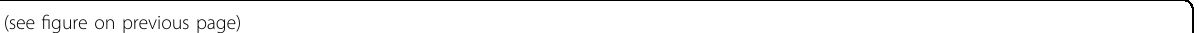
Fig. 2 Single-agent APG-115 signi fi cantly reduces the leukemic burden and prolongs survival in systemic TP53 wt MOLM-13 AML xenografts. A Study schema of the experimental paradigm to study tumor burden and animal survival in the systemic MOLM-13 AML model. For CD45 analysis, mice were treated with APG-115 for 15 days. For survival analysis, mice were treated with APG-115 for 21 days. B Representative fl ow cytometry results show tumor burden (i.e., engraftment of human CD45 + cells) in murine femoral bone marrow and spleen. Five or six mice treated as in A from each treatment group were euthanized and examined on Day 15. C Signi fi cantly lower proportions of human CD45 + cells in the bone marrow and spleen collected from mice exposed to APG-115 (treated as in A) compared to vehicle (** p < 0.01 by two-tailed Student tests). D Kaplan – Meier proportional-hazards plots show signi fi cantly increased percentage survival in mice receiving APG-115 per the dosing conditions shown in A (~50 days) compared to mice receiving vehicle. APG-115 prolonged median survival time by 18.5 days compared to vehicle control (37.0 vs. 18.5 days), p < 0.0001 by log-rank test; n = 9 – 10 mice. CTX cyclophosphamide, IP intraperitoneally, NOD SCID nonobese diabetic severe combined immunode fi cient, PO orally, QOD every other day. E APG-115 confers signi fi cantly increased in vivo survival compared to RG-7388 in a systemic AML xenograft model derived from TP53 wild-type MOLM-13 cells. NOD SCID mice intravenously implanted with 1 × 10 7 MOLM-13 cells ( n = 10/group) were treated 3 days after cell inoculation. APG-115 and RG-7388 were orally administered daily for 7 days. Kaplan – Meier curve depicts mouse survival. * p < 0.05 by log-rank